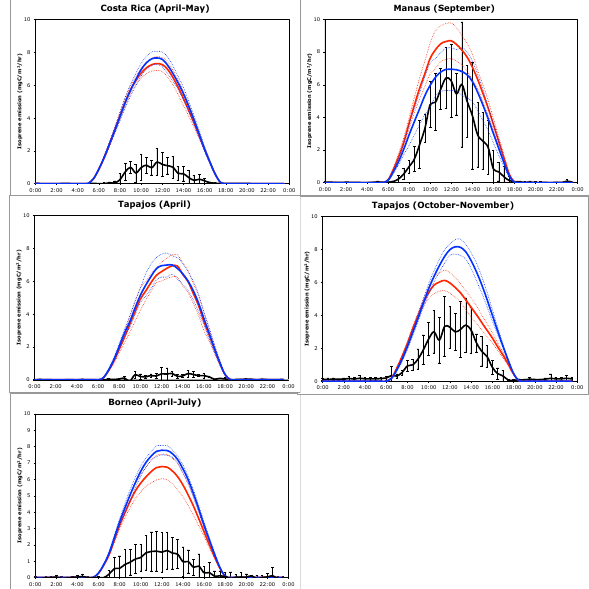
Fig. 9a. (a–c) Comparison between measured and modeled isoprene diurnal cycles at the tropical sites during the time periods indicated in Table 6. Measurements are black lines. Error bars on the measurements represent ± 1 standard deviation. Model results are 10-year climatological averages for SimCONT (red) and SimH2O (blue). The dotted lines represent model uncertainty due to internal variability in the climate model computed as ± 1 standard deviation for n=10 model run years. Wet season results are shown in the left column and dry season results are shown in the right column.